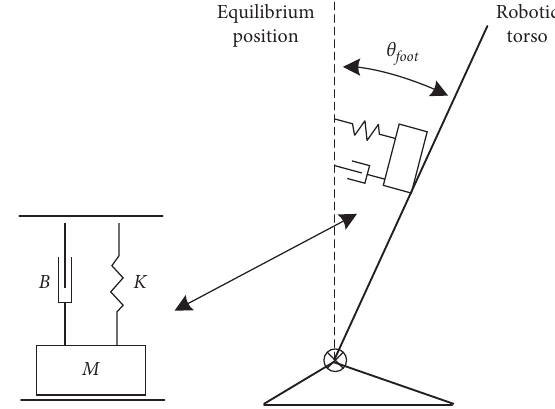
Figure 3: The bipedal robot ankle impedance model’s schematic